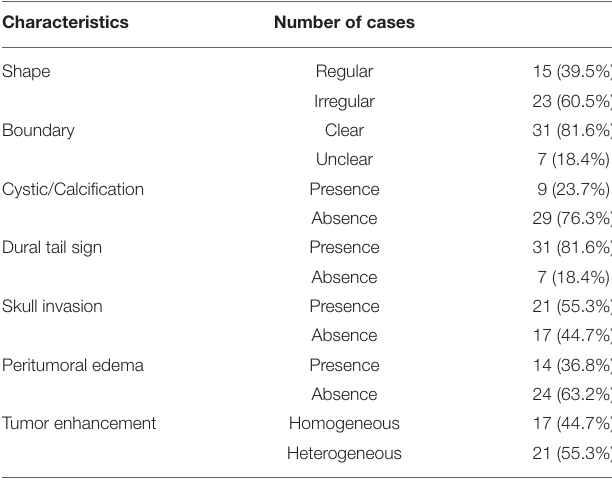
TABLE 3 | Radiological features of available 38